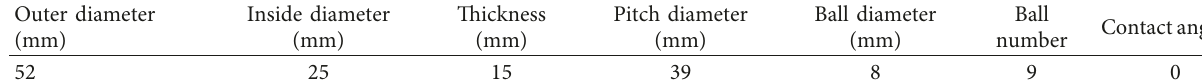
Table 3: Structural parameters of the bearing.